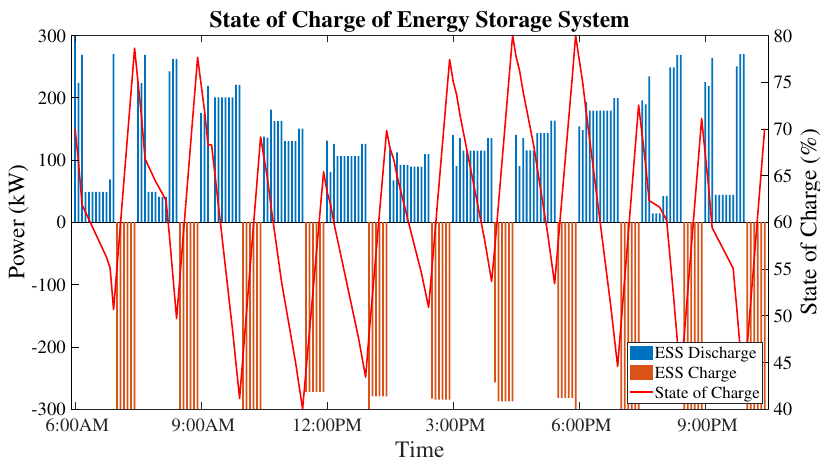
Figure 15. State of charge of energy storage system (case study